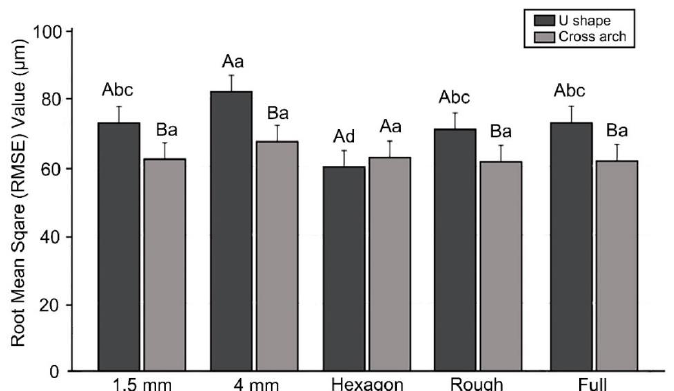
Figure 7. Precision comparison between Groups P and U. Lowercase letters indicate significant differences between internal structures within the Groups U or P each, and uppercase letters indicate significant differences between Groups P and U within the same internal-structure.